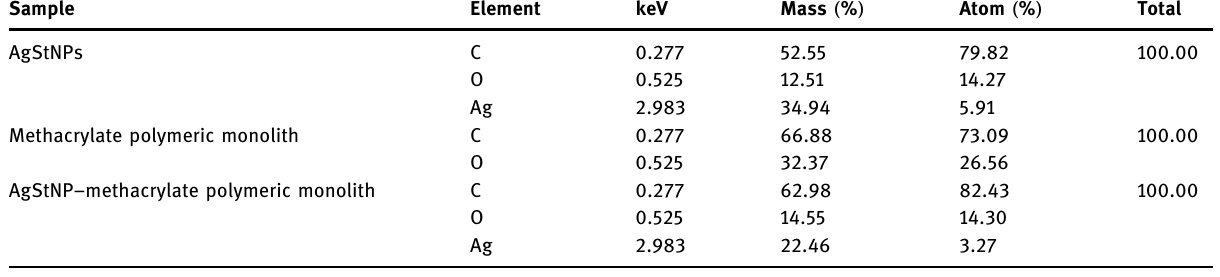
Table 1: Atomic percentage of element of AgStNPs, organic monolith, and AgStNP – methacrylate polymeric monolith Sample